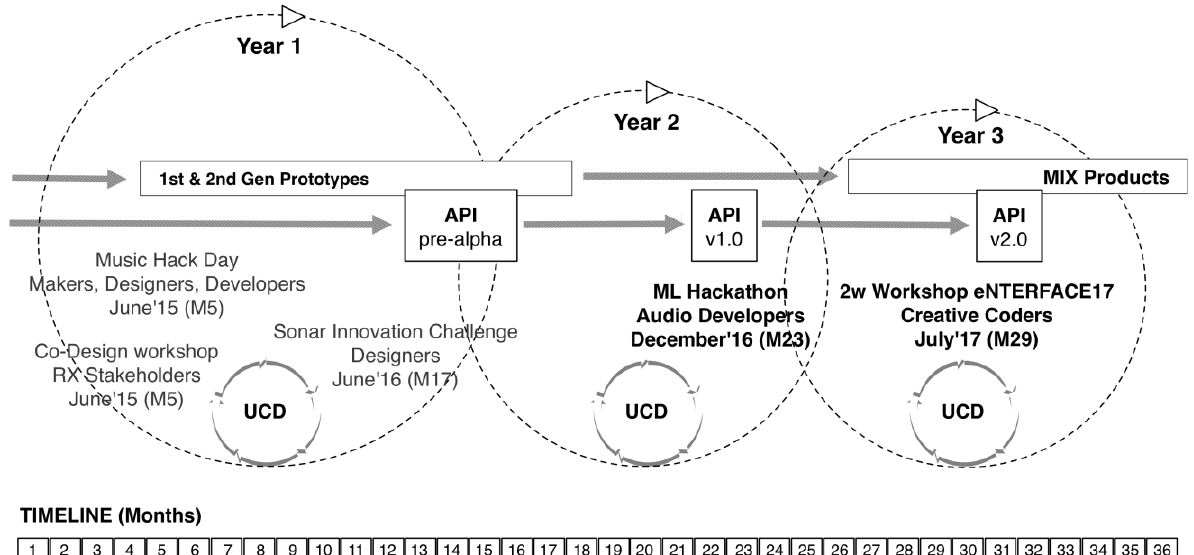
Figure 1 | RAPID-MIX UCD framework with selected UCD